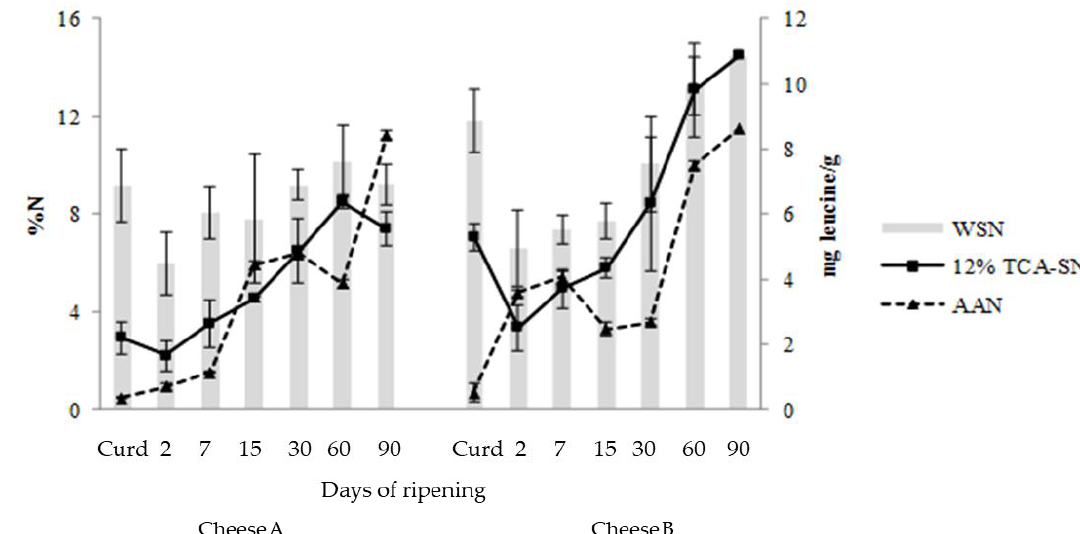
Figure 1. Evolution of nitrogen fractions during ripening in Cheeses A and B. WSN: water-soluble nitrogen; TCA-SN: trichloroacetic acid-soluble nitrogen; AAN: amino acid nitrogen.